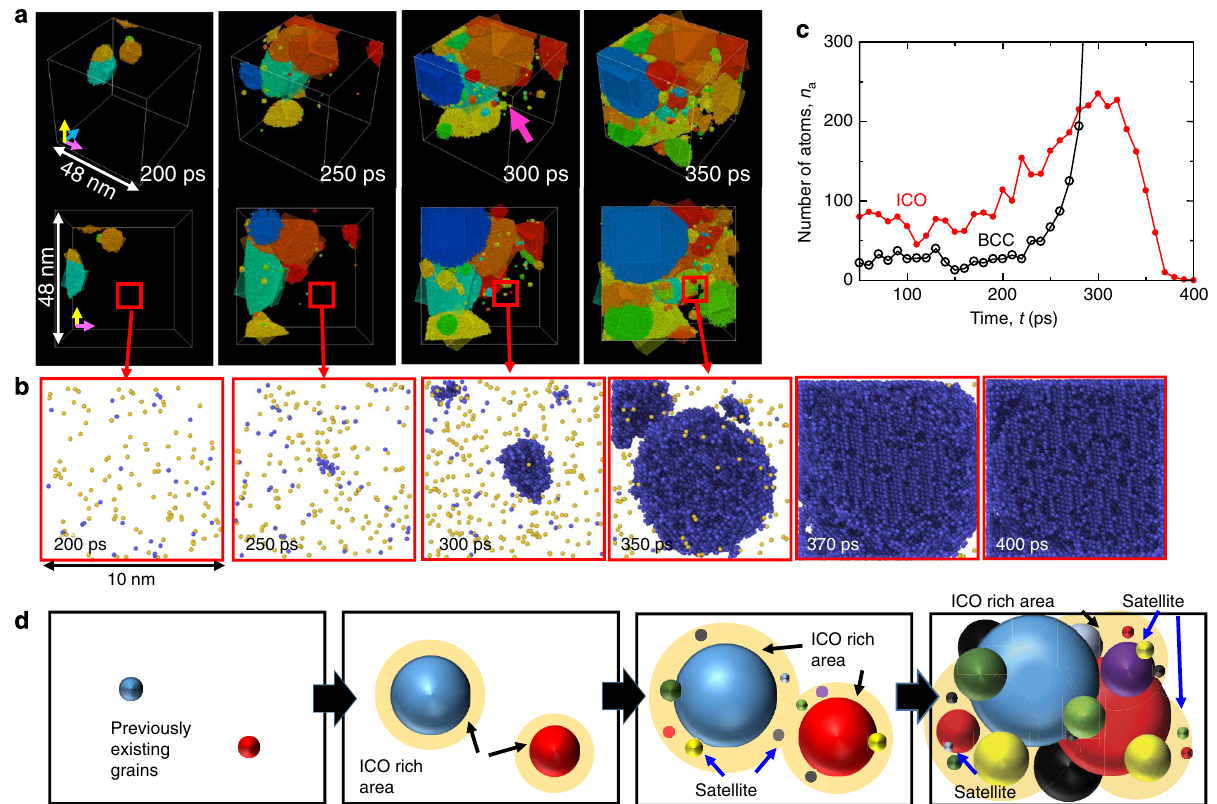
Fig. 6 Satellite-like small grains near the surface of previously existing grains. a Snapshots of part of the simulation cell between 200 and 350 ps in the calculation for 0.67 T m (i.e., bird ’ s-eye and side views). b Snapshots of the atomic con fi guration in the part of the simulation cell (10 × 10 × 10 nm 3 ) indicated by the red squares in a , where satellite-like small grains nucleate near one of the previously existing grains. Only atoms with the bcc ( blue atoms ) and ICO ( yellow atoms ) con fi gurations, as classi fi ed by adaptive CNA, are shown for clarity of the fi gures. c Time changes in the numbers of atoms classi fi ed as having bcc and ICO con fi gurations, where all the atoms in the cell in b are counted. d Schematic illustration of the formation process of satellite-like grains in ICO-rich areas near the surface of previously existing grains